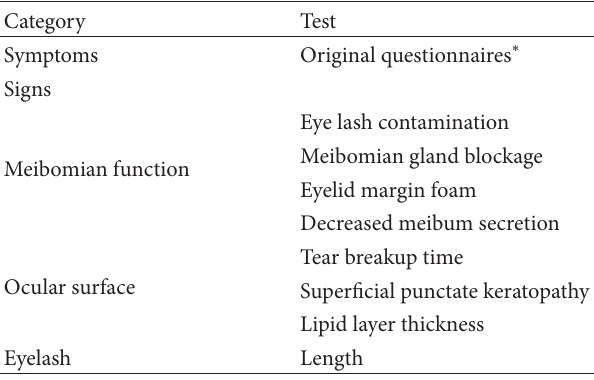
Table 4: Specialized and nonspecialized tests for meibomian gland dysfunction, dry eye, and eyelash